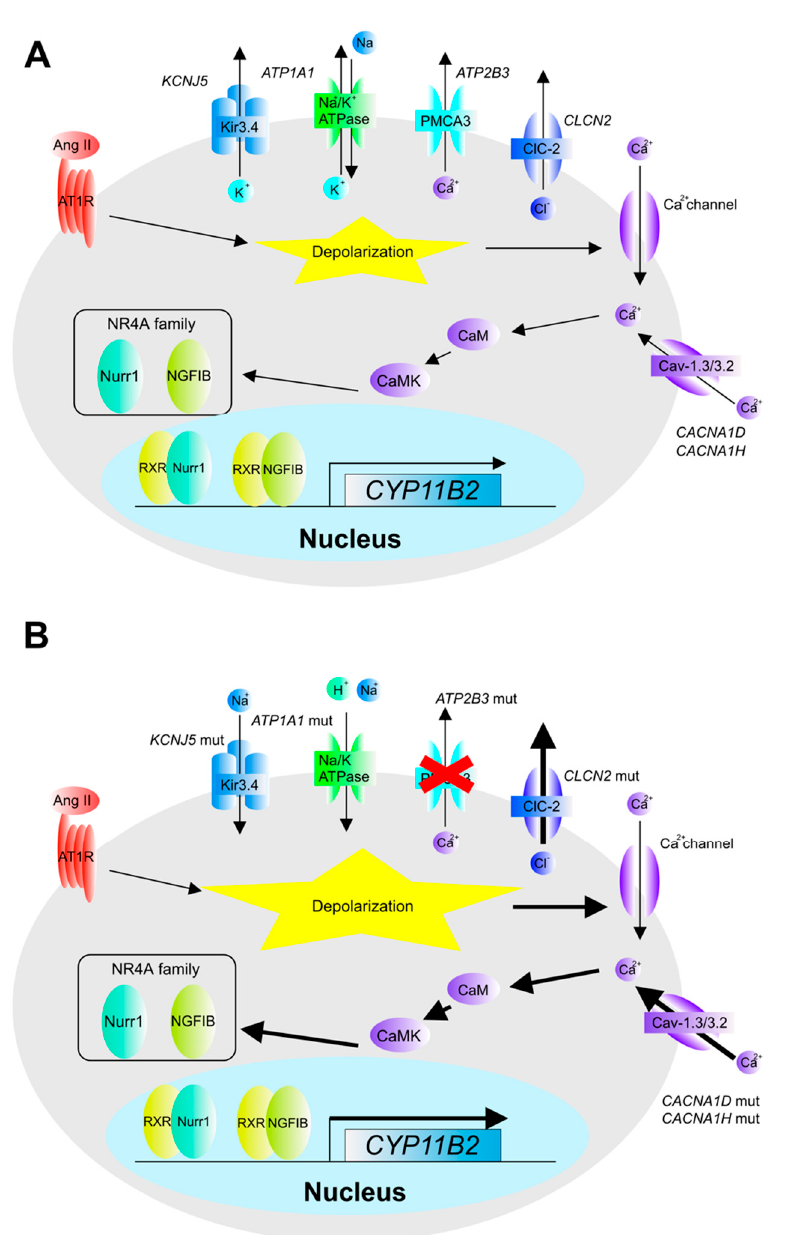
Figure 2. Gene mutations of membrane protein in APA. Depolarization of the plasma membrane is the common consequence in this mechanism. ( A ) Normal adrenal membrane proteins. ( B ) Gene mutation in adrenal membrane proteins. KCNJ5 mutation causes inflow of sodium ion; ATP1A1 mutation causes hydrogen and sodium ion leak; ATP2B3 mutation causes impaired calcium ion release; CLCN2 mutation causes impaired chloride ion release; and calcium ion influx is due to mutations in CACNA1D and CACNA1H